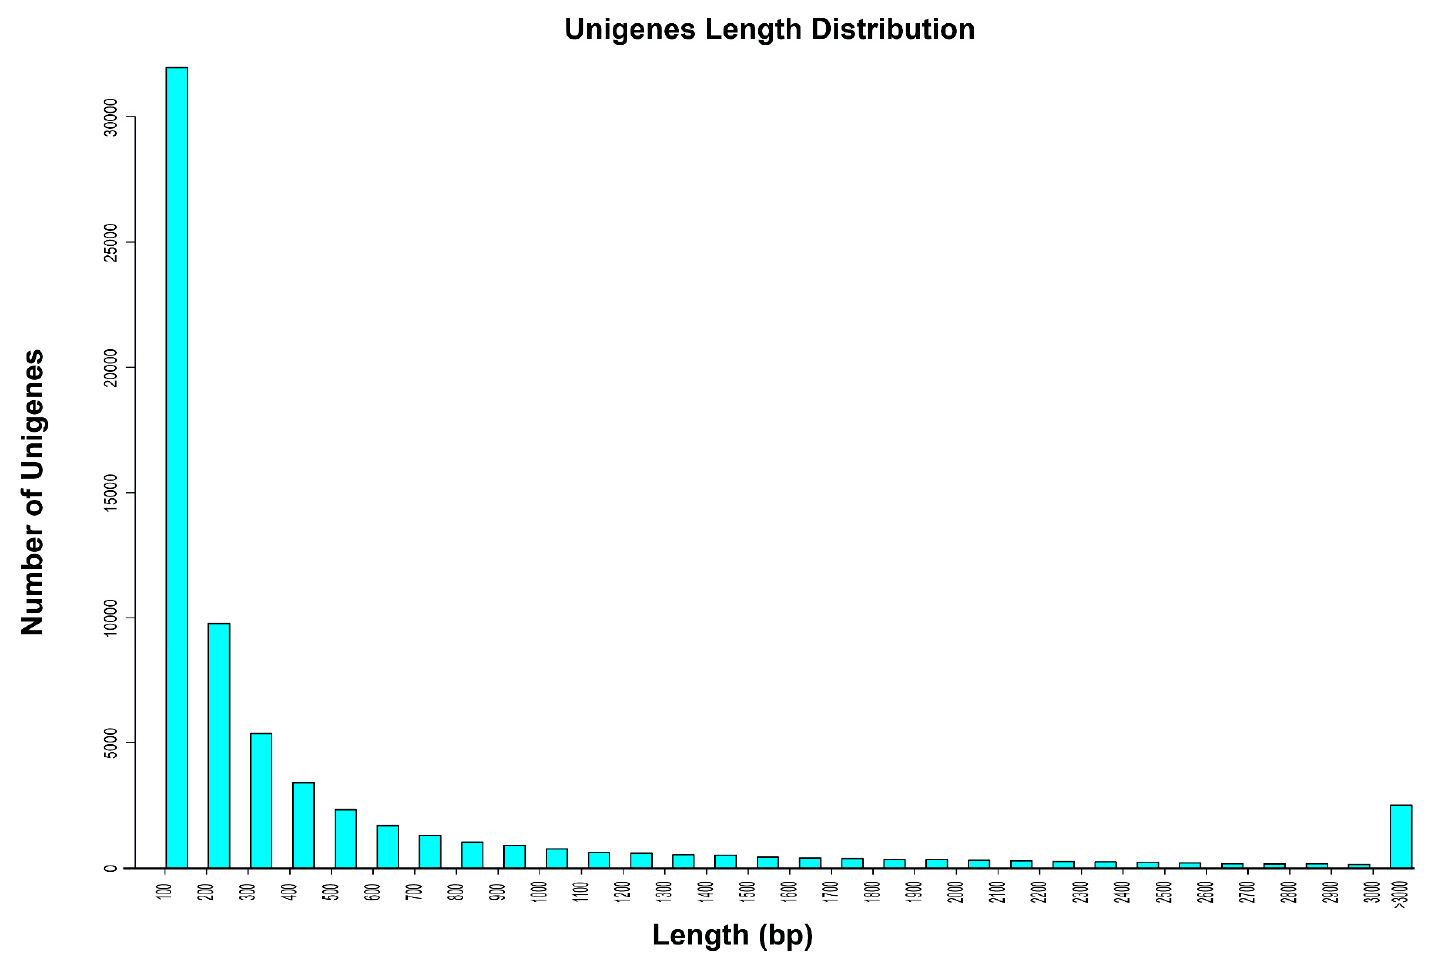
Figure 1. Sequence-length distribution of uni-genes. The x -axis represents the length range, the Y-axis is the number of uni-genes.